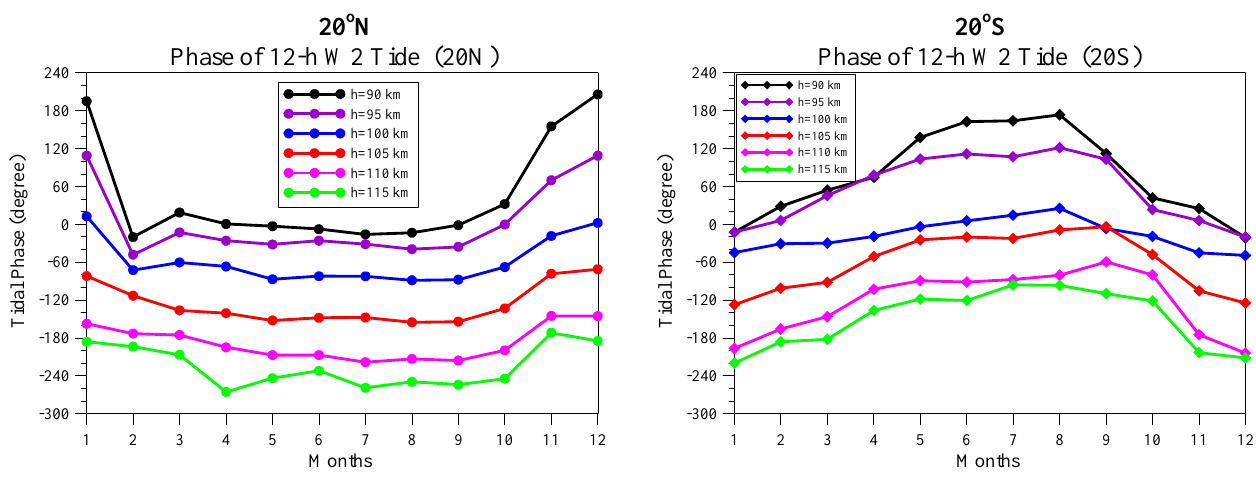
Figure 9 Fig. 9. Average (2002–2007) monthly tidal phases for the altitude range between 90 and 115km marked by different colors (black for 90km; purple for 95km, blue for 100km, red for 105km, magenta for 110km and green for 115km) for 20 ◦ N (left plot) and 20 ◦ S (right